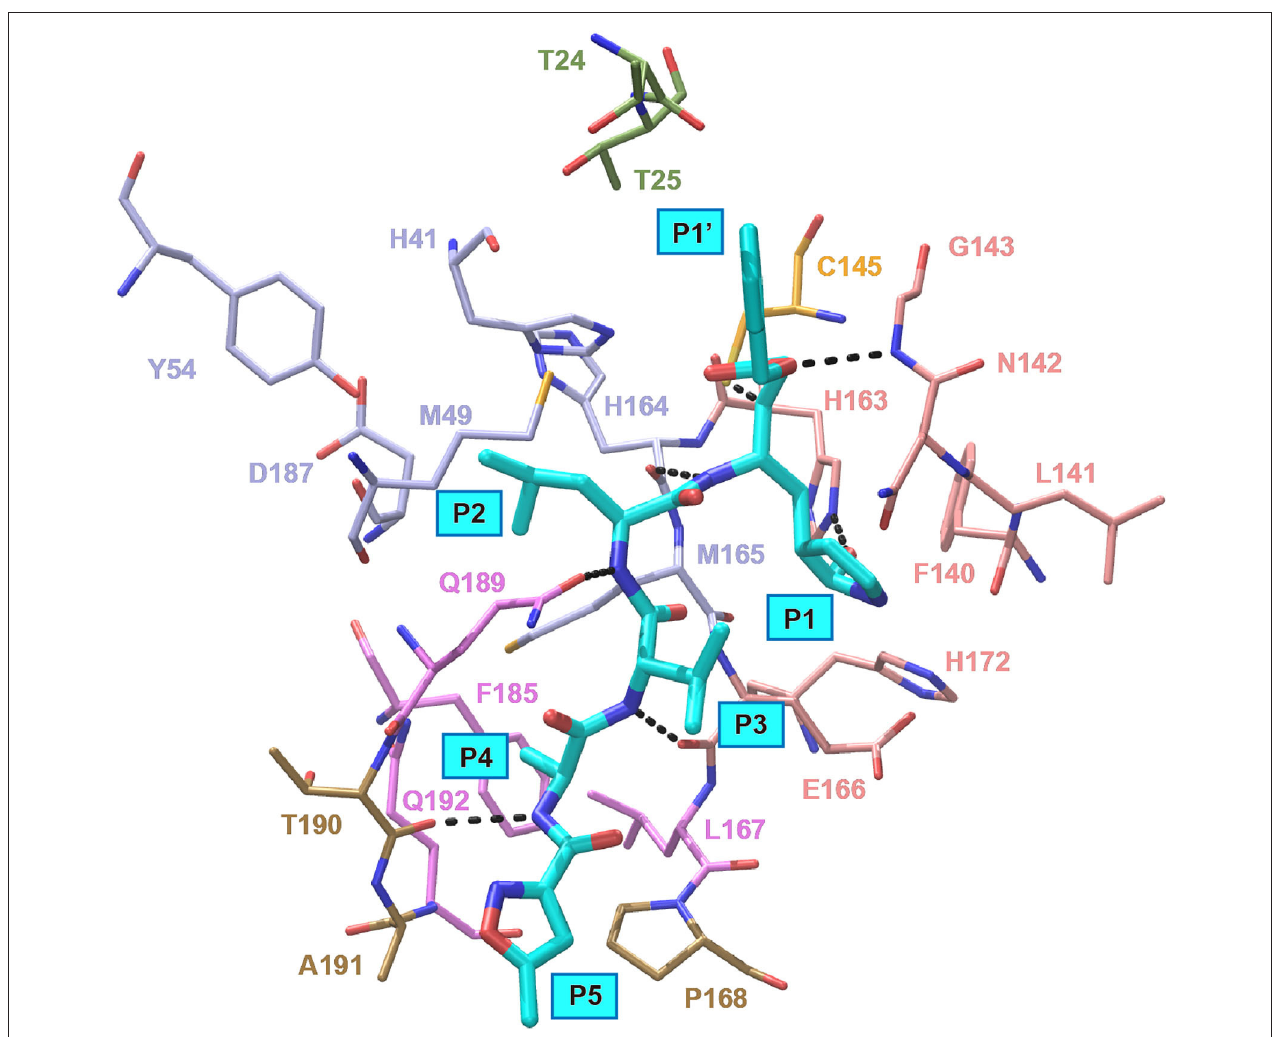
FIGURE 2 | Interaction pattern between N3 and SARS-CoV-2 M pro . N3 is shown as cyan sticks, the residues interacting with P1 ′ are shown as green sticks, the residues forming the S1 site are shown as salmon sticks, the residues forming the S2 site are shown as light blue sticks, the residues forming the S4 site are shown as violet sticks and the residues interacting with P5 are shown as sand sticks. Intermolecular hydrogen bonds are shown as dashed lines.